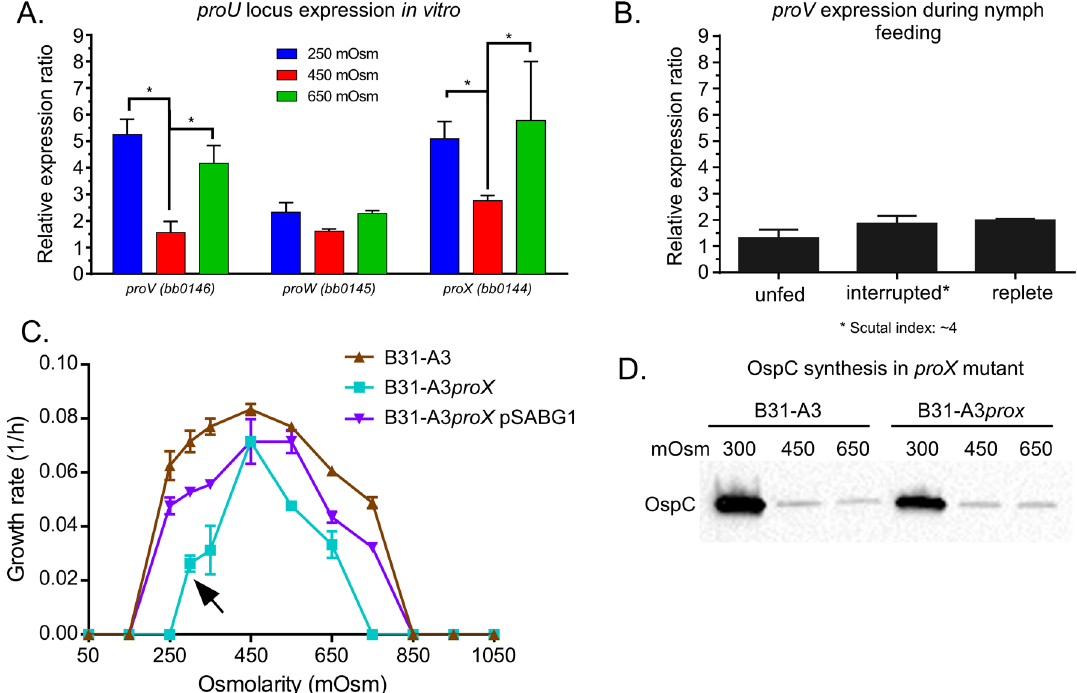
Fig 6. The ProU system and its role in osmotolerance. (A) In vitro expression of the three genes of the proU locus: proV , proW and proX at 250, 450 and 650 mOsm. Gene expression was normalized to enoS . (B) proV expression during nymph feeding. (C) Rate of growth of strains B31-A3, B31-A3 proX and B31-A3 proX pSABG1 at osmolarities ranging from 150 to 1050 mOsm under microaerobic conditions. The arrow denotes growth at 300 mOsm. (D) Immunoblot of cell lysates (40 μ g of protein/lane) of B . burgdorferi B31-A3 and B31-A3 proX cells grown at 300, 450 and 650 mOsm to mid-log phase and probed with OspC-specific